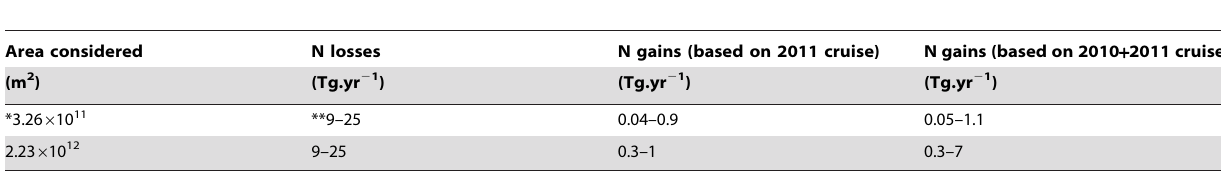
Table 3. Comparison between estimated fixed N losses via denitrification and anammox and fixed N gains via N 2 fixation (estimated from the 0–2000 m depth integrated rates measured in this study) in the ETSP.